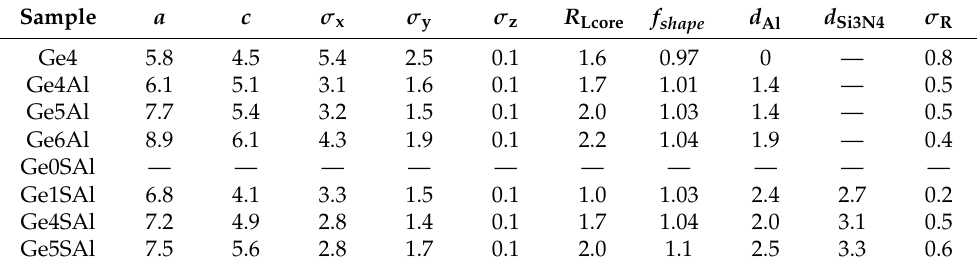
Table 2. Parameters of the Ge QD lattices determined from the GISAXS analysis: QDs